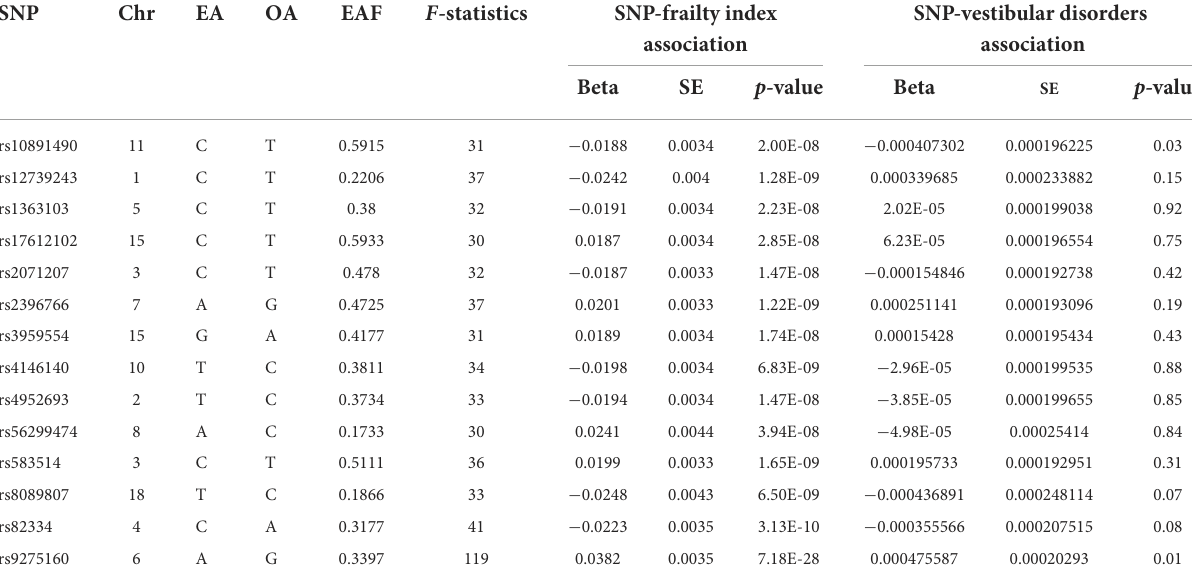
TABLE 1 The characteristics of 14 SNPs and their genetic associations with frailty index and vestibular disorders.